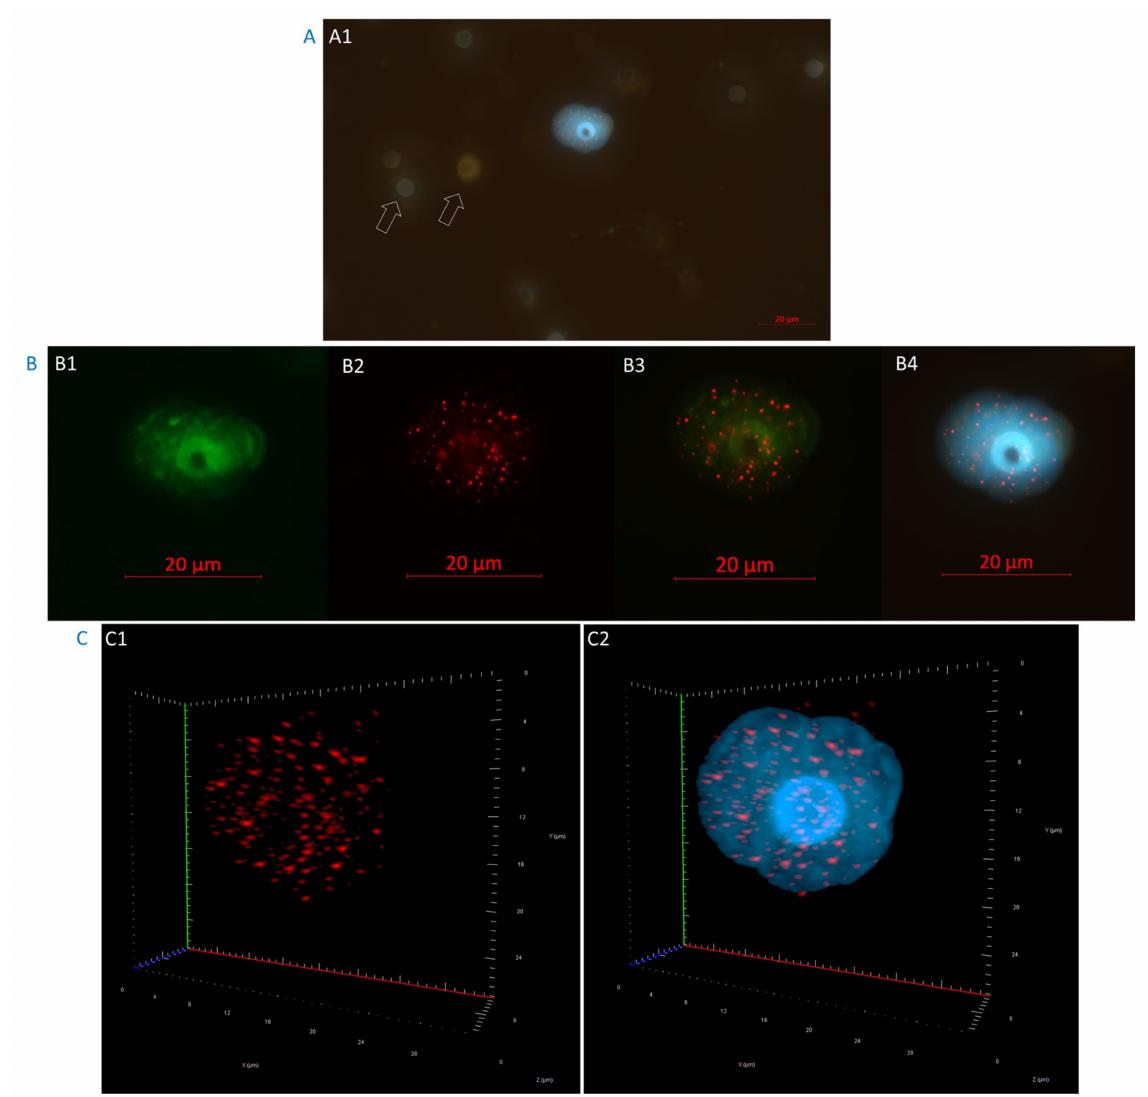
Figure 2. Example of a circulating tumor cell from a high-risk localized prostate cancer patient captured on top of a filter pore ( A ) (The arrows show empty filter pores). The prostate cancer CTCs are recognized based of their AR positive staining ( B ). ( B1 ) Two-dimensional image showing a CTC AR + in FITC (green); ( B2 ) CTC with the telomeres labeled with telomere-specific Cy3-labeled probe (red); ( B3 ) Merge between FITC and telomeres; and ( B4 ) CTC counterstained with DAPI in blue. In C ( C1 and C2 ), the same cell is shown in three-dimensional representation. Red spots represent telomere signals; and the blue is